Question: Condense the content of this figure into a single sentence.
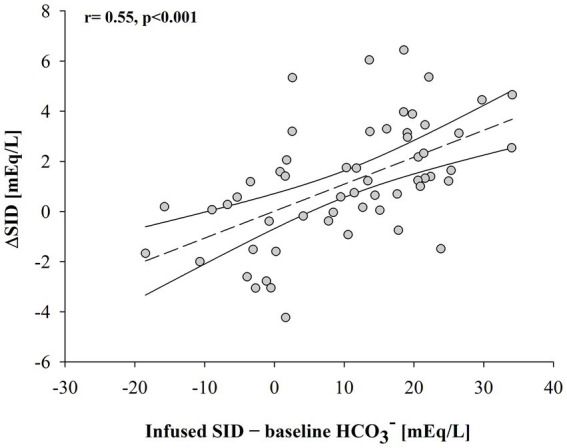
Answer: Association between the average difference between SID infused (SID INF ) and plasma bicarbonate concentration and plasma SID (SID PL ) difference. Pearson’s r = 0.55, p < 0.001. Model’s equation: ΔSID = 0.11 ⋅ ( SID INF − HC O 3 − ) + 0.02.